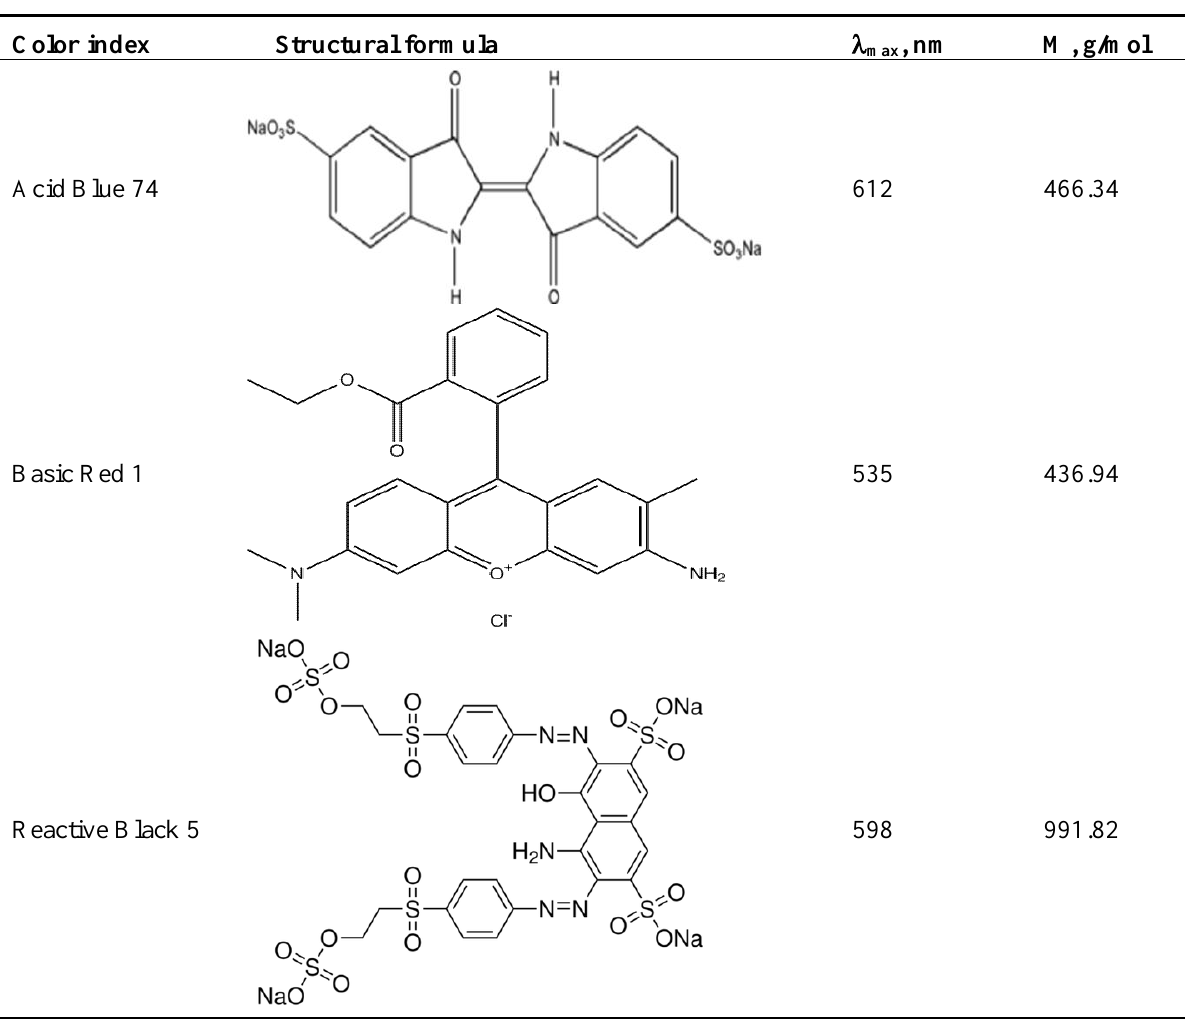
Table 1. Structural chemical formula of investigated dyes: Acid Blue 74; Basic Red 1 and Reactive Black